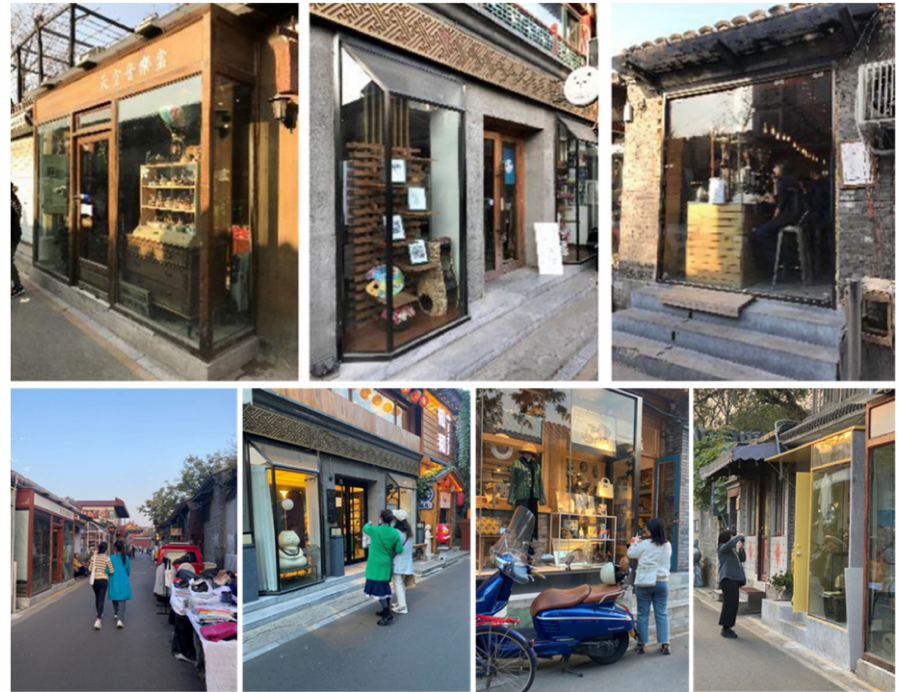
Figure 9. Commercial building units with high interface transparency and the subsequent tourists’ walking-stopping behaviors.